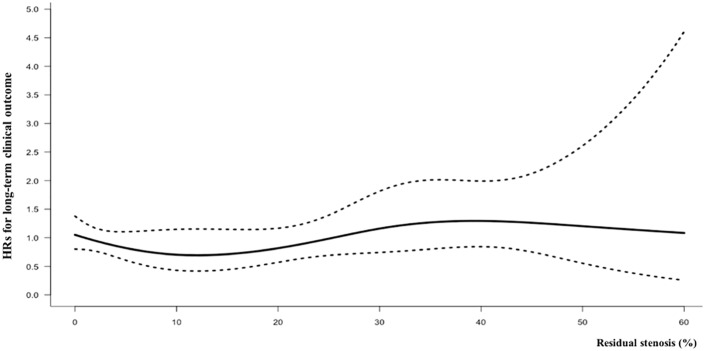
The adjusted hazard ratios of residual stenosis for clinical outcome.The solid line indicates the hazard ratio, and the dotted line indicates the 95% confidence interval. HR, hazard ratio.